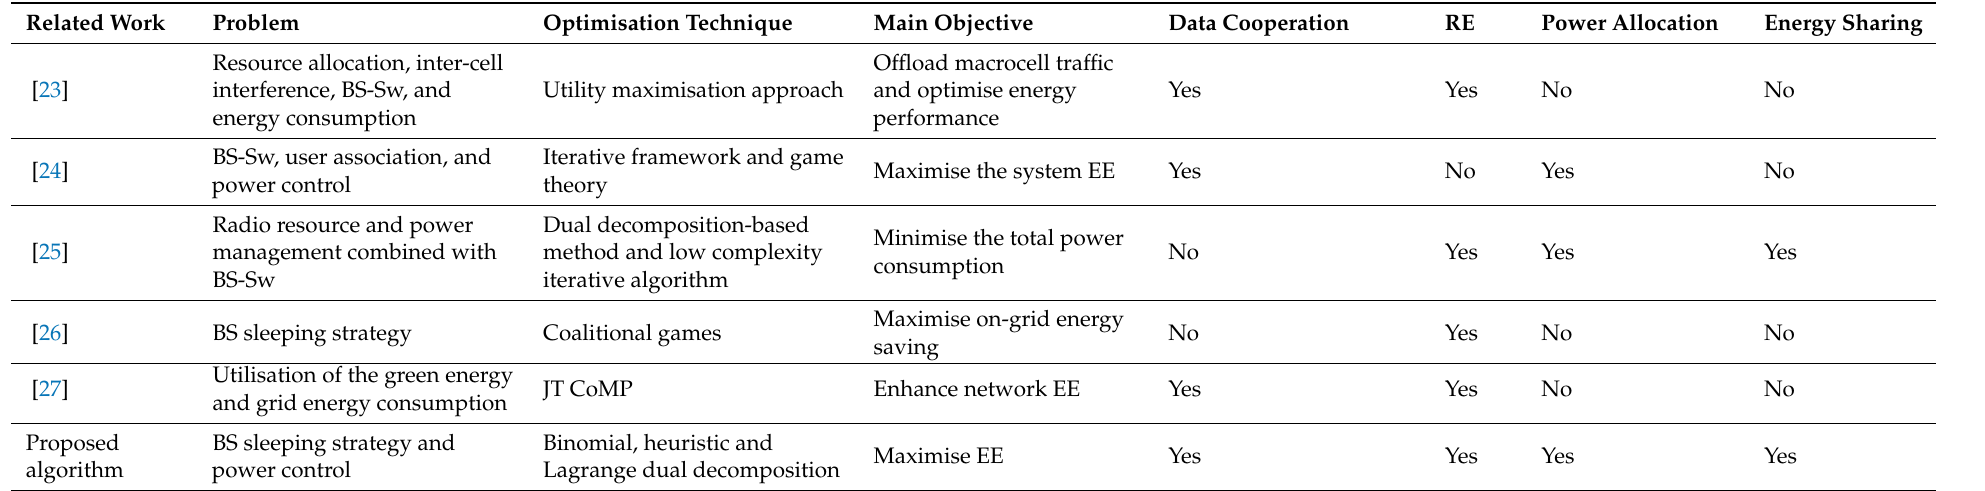
Table 1. Summary of the relevant work that employs